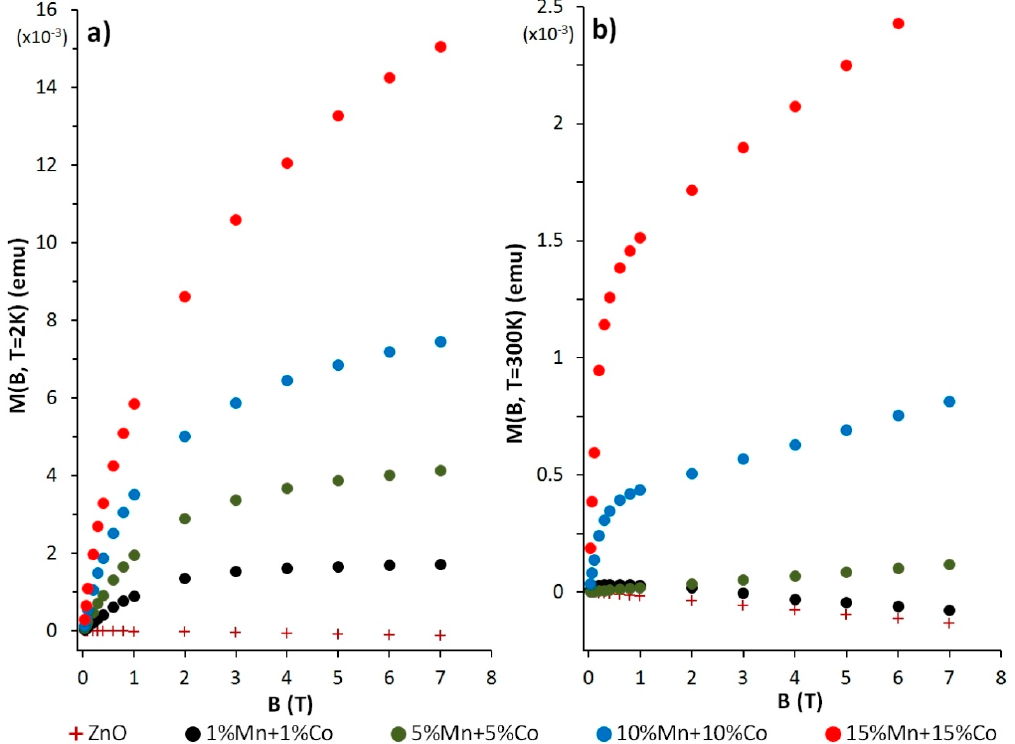
Figure 10. Measured magnetisation as a function of the magnetic field: ( a ) Zn (1 − x − y) Mn x Co y O—temperature—2 K, ( b ) Zn (1 − x − y) Mn x Co y O—temperature 300 K. Red full points—Zn 0.70 Mn 0.15 Co 0.15 O, blue—Zn 0.80 Mn 0.10 Co 0.10 O, green—Zn 0.90 Mn 0.05 Co 0.05 O, black—Zn 0.98 Mn 0.01 Co 0.01 O, brown crosses—pure ZnO.